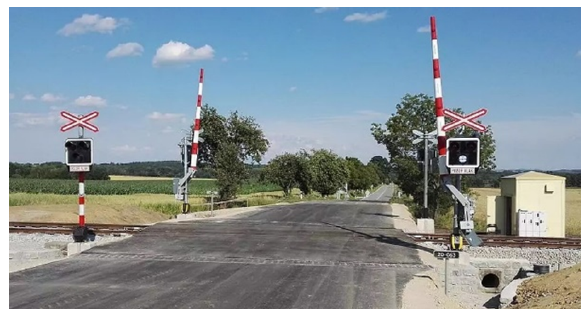
Figure 5. RC secured by a light device with mechan- ical barriers [ zdopravy.cz ].